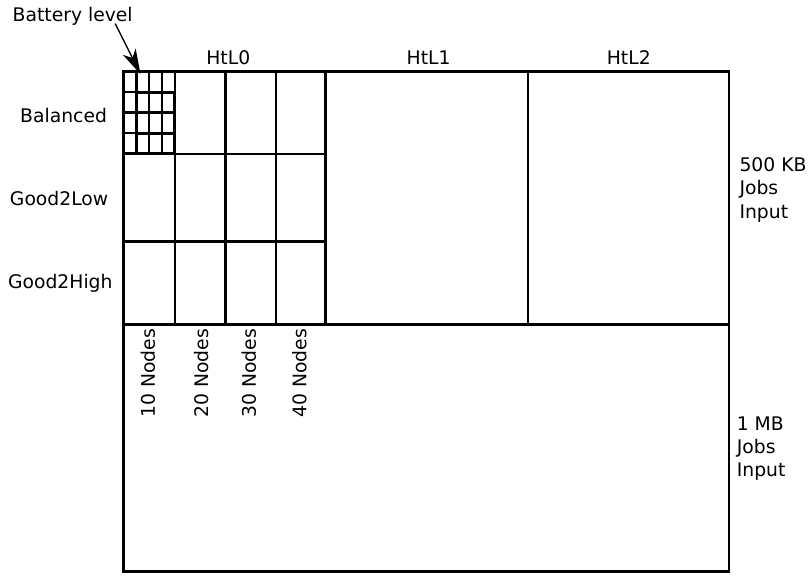
Figure 3. Simulated scenarios: heatmap